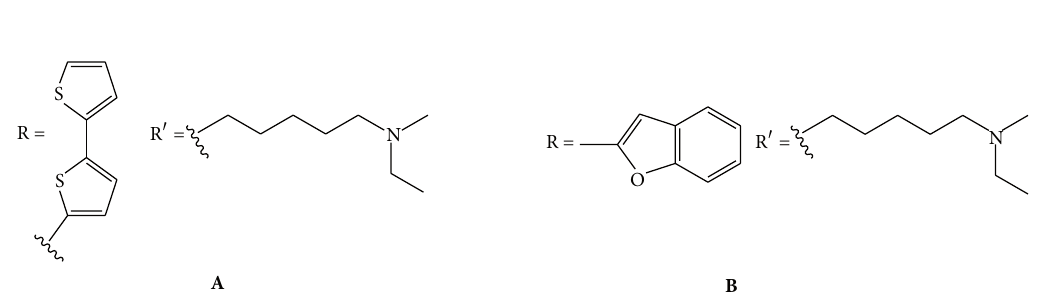
Figure 15: Chemical structures of compounds